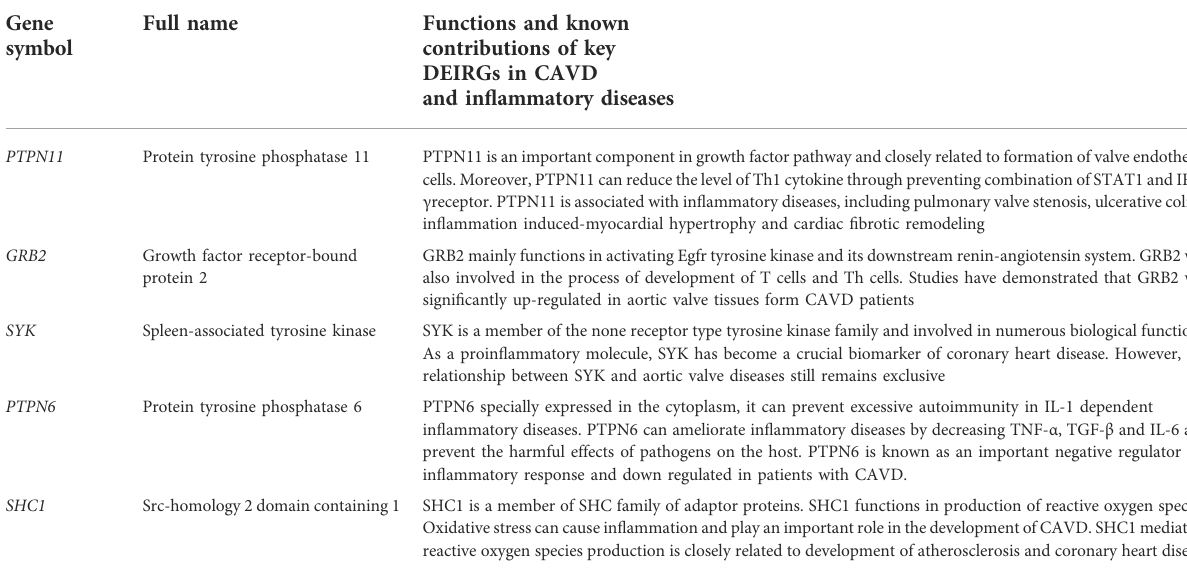
TABLE 2 Summary of the functions and known contributions of key DEIRGs in CAVD and other in fl ammatory